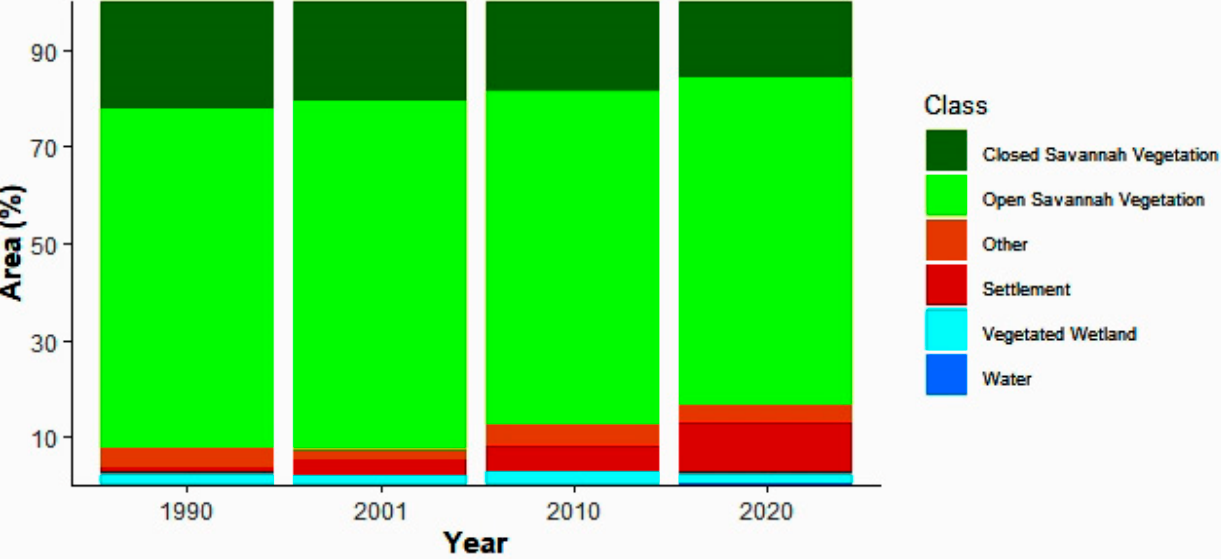
Figure 4. The proportion of LULC change in Wa Municipality for the respective time slices.